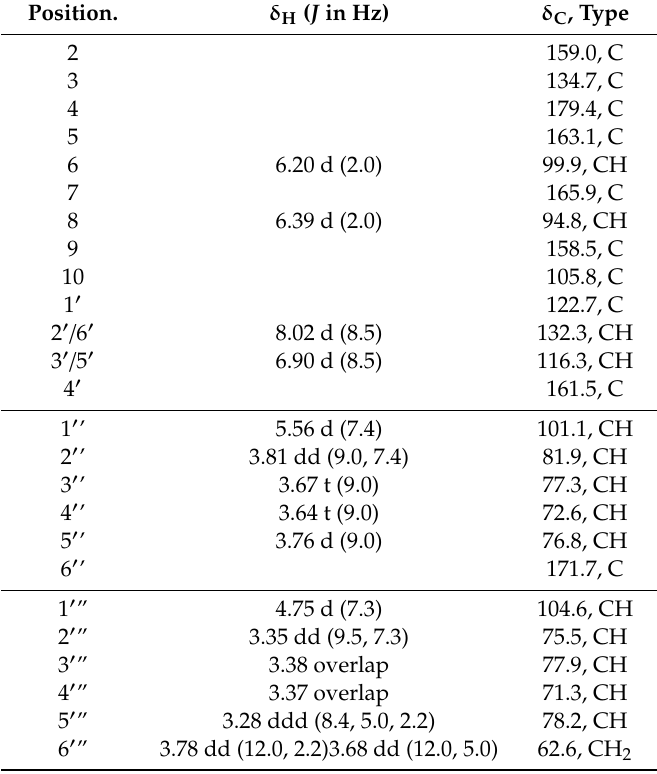
Table 2. 1 H- and 13 C-NMR data (MeOH- d 4 + 0.1% trifluoroacetic acid, 500 / 125 MHz, 30 ◦ C) for compound 22